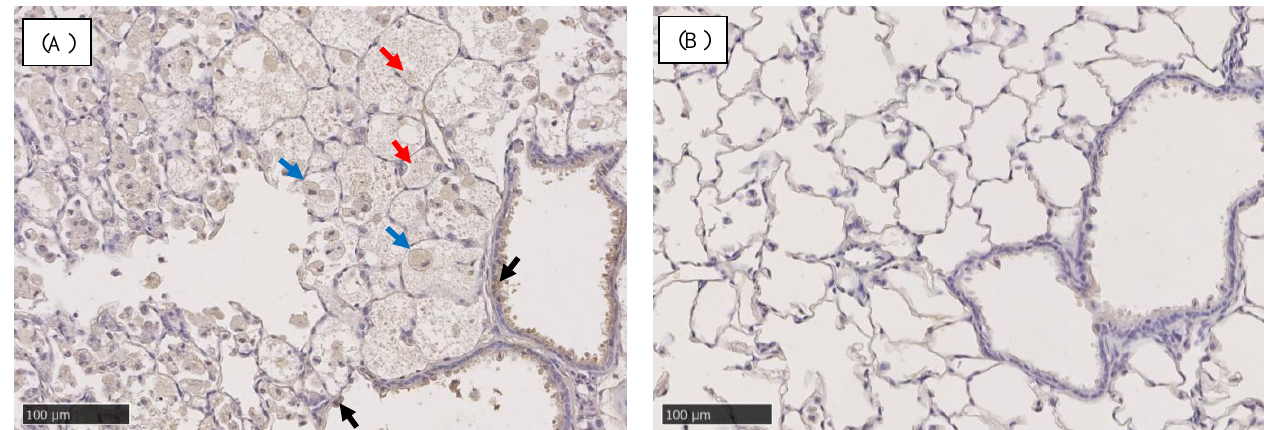
Figure 5. Immunostaining of SP-D in lung at 3 months after exposure. ( A ) 1 mg NiO-exposed lung. ( B ) Negative control in intratracheal instillation (distilled water). Positive staining of SP-D was observed in type II alveolar epithelial cells (black arrow), alveolar macrophages (blue arrow) and alveolar mucus (red arrow) in Figure 5A.